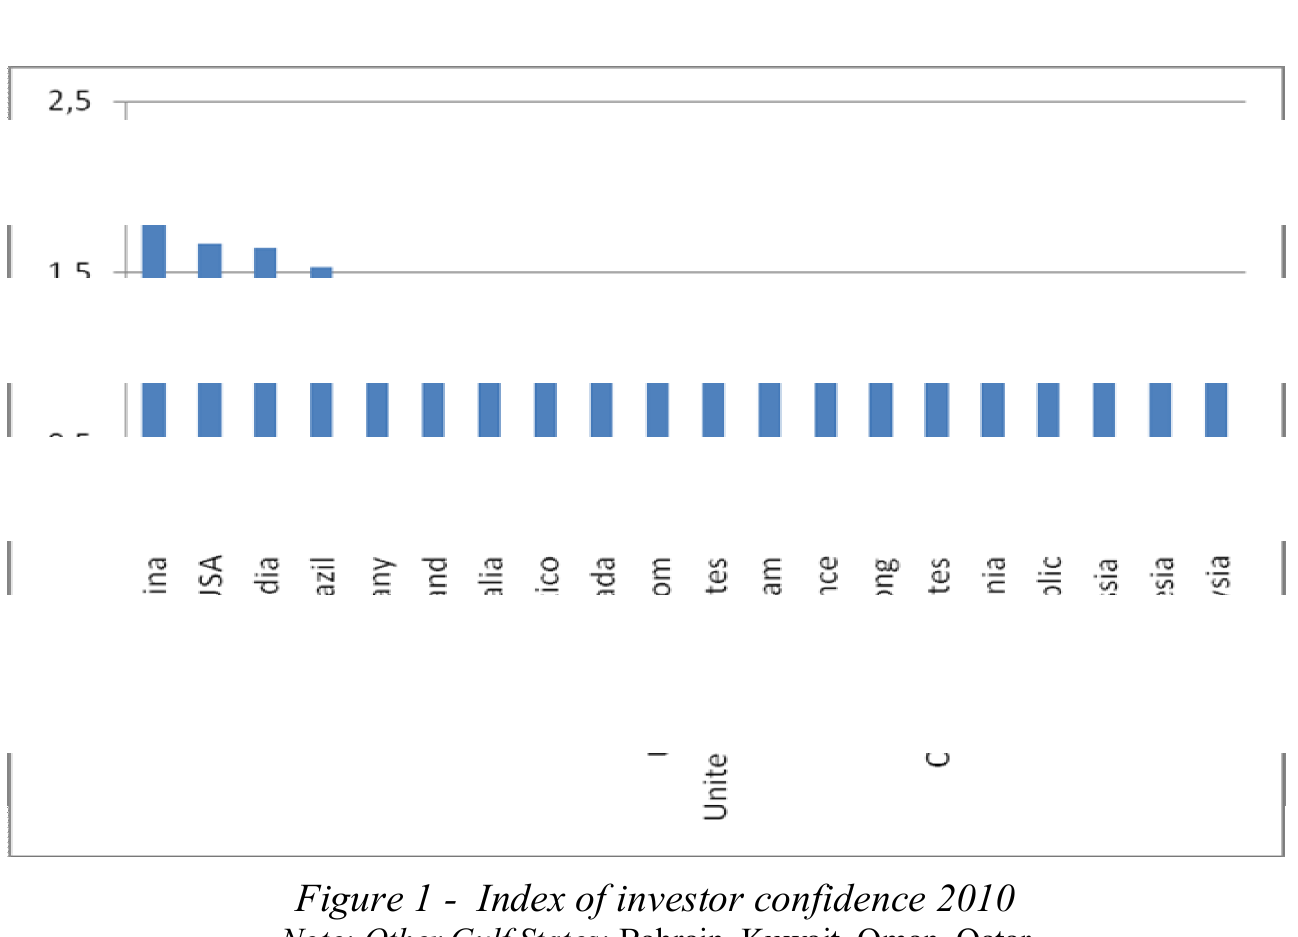
Figure 1 - Index of investor confidence 2010 Note: Other Gulf States: Bahrain, Kuwait, Oman, Qatar Source: www.atkearney.com